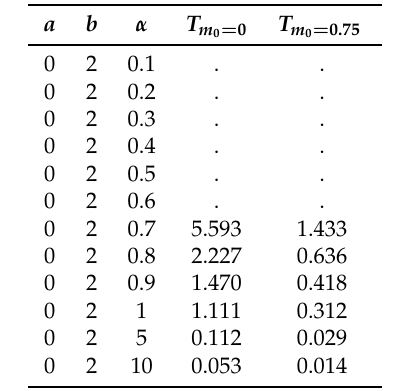
Table 5. Solvability of the ODE (52) with the states a = 0 and b = 3. a b